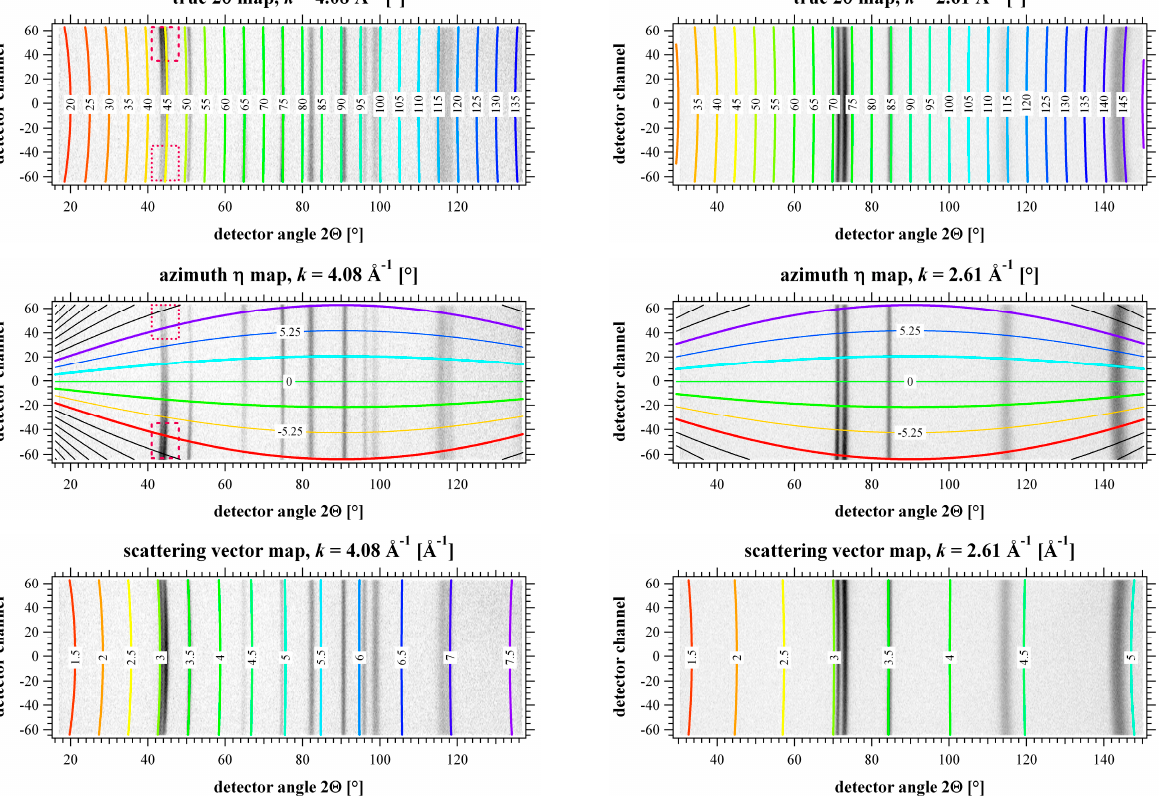
Figure 4. WOMBAT detector maps for the two selected settings, k 1 = 4.08 Å − 1 , 2 Θ 0 = 16.0° ( left ) and k 2 = 2.61 Å − 1 , 2 Θ 0 = 29.4° ( right ), representing contour lines of true 2 θ , azimuth η , and scattering vector Q . The contour maps are superimposed on various actual detector images showing different 2D diffraction patterns obtained from the texture measurements of the investigated steel, and demonstrating intensity variations on the Debye–Scherrer rings, as indicated in the square boxes. Indexing of the h , k , l reflections is given in Figure 5.